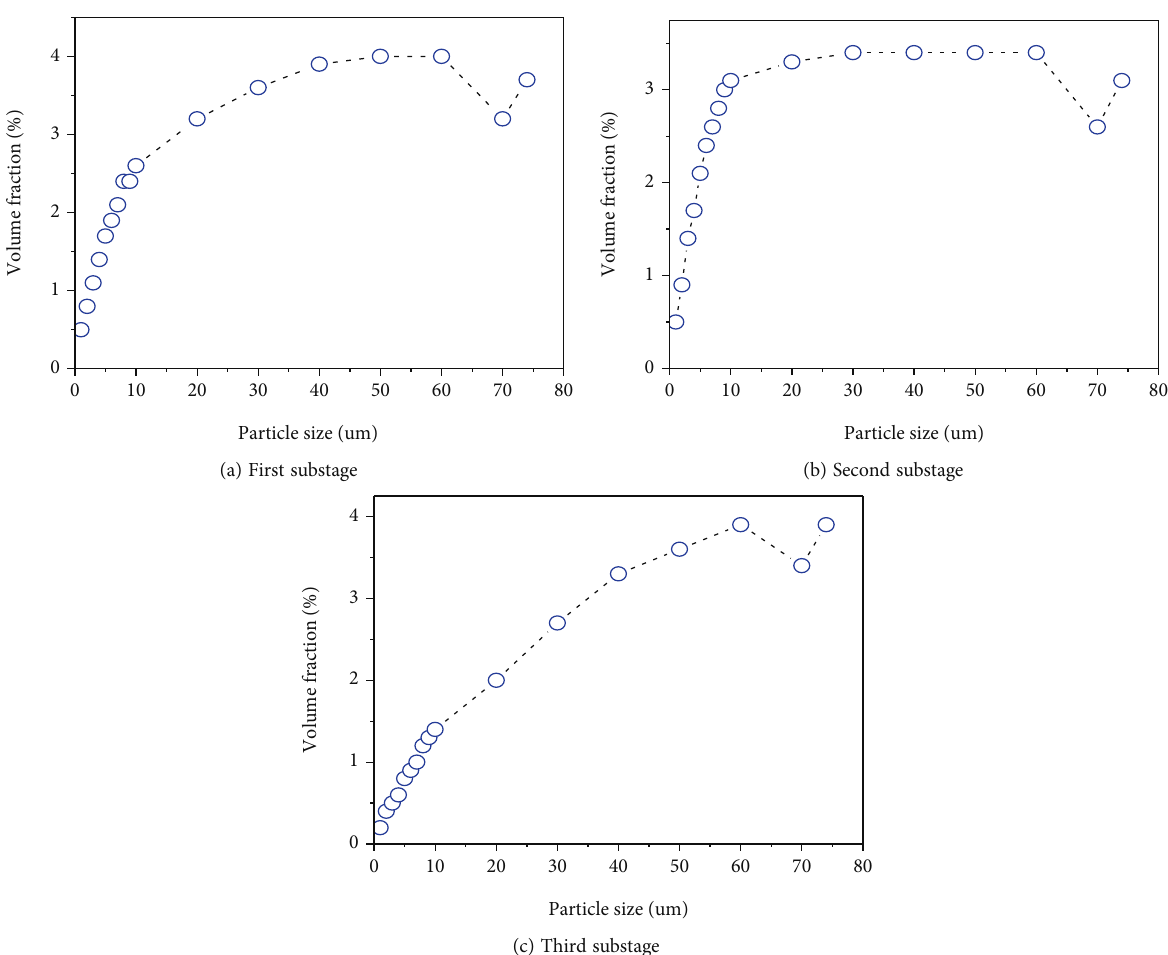
Figure 9: Comparison of particle size with the original sample under di ff erent head di ff erences.